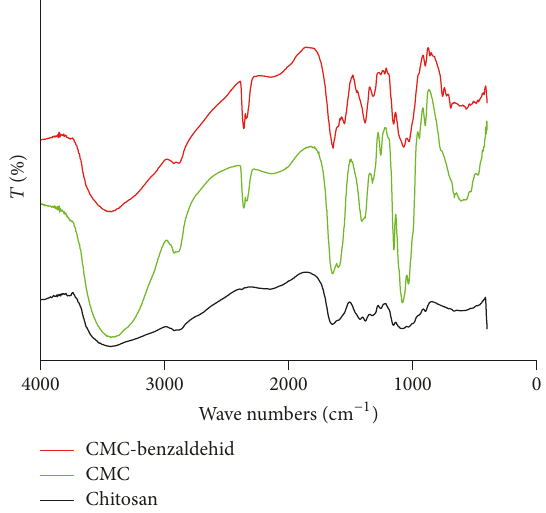
Figure 7: FTIR spectrum of chitosan, CMC, and CMC-